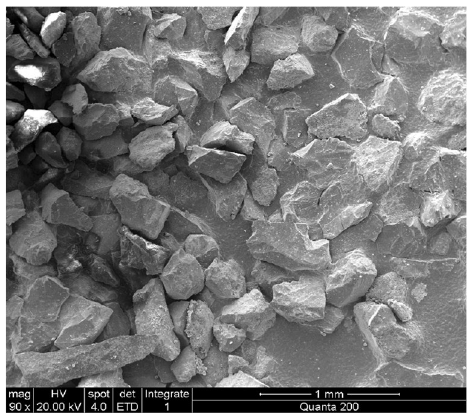
Fig. 8 The combustion front propagation in the model for 40 m